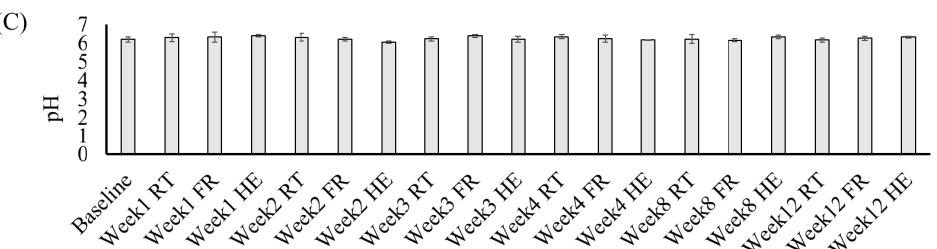
Figure 5. The changes in the total phenolic content ( A ), viscosity ( B ), and pH ( C ) of the MELM were stored under different conditions for 12 weeks.